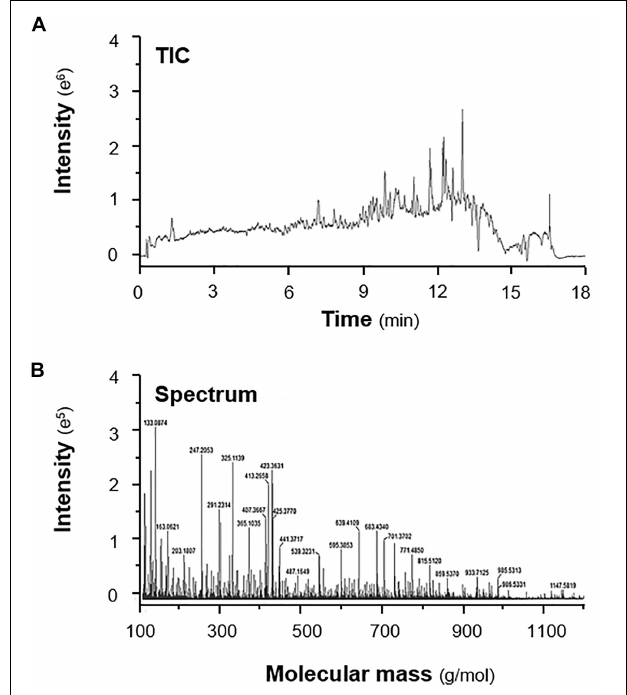
FIGURE 4 | A typical total ion chromatogram (TIC) and mass spectrum. The 90% ethanol extract of Ginseng was served as an example. (A) Total ion chromatogram (TIC) and (B) mass spectrum of the Ginseng extracts are shown. The X-axis of TIC is time (min); while the X-axis of spectrum is mass (Da). Both profiles were obtained with a Xevo G2-XS R (cid:13) Quadrupole Time-of-Flight (Q-TOF) Mass Spectrometer coupled with an integrated ACQUITY UPLC R (cid:13) I-Class System. The mobile phase was composed of acetonitrile and water, and the effluent was analyzed with an ESI ion source in positive mode. The acquisition range was set from 50 to 1200 Da with 0.1 s scan rate to reveal most of the chemicals within the herbal extracts. The extracts from 3 batches of herbs were subjected to analysis, a representative profile was